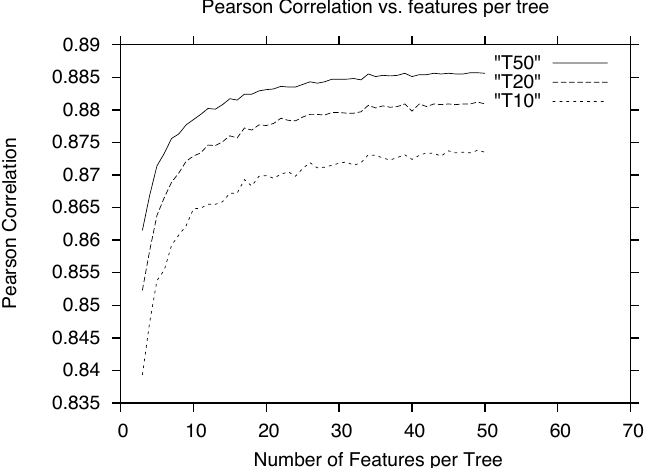
Figure 3. The Pearson correlation between the fraction of GZ1 humans voting for spiral, and our reproduction of that vote fraction, as a function of the number of features per tree that are chosen at random from the entire feature set. The three curves correspond to the cases where the total number of trees is 10, 20, or